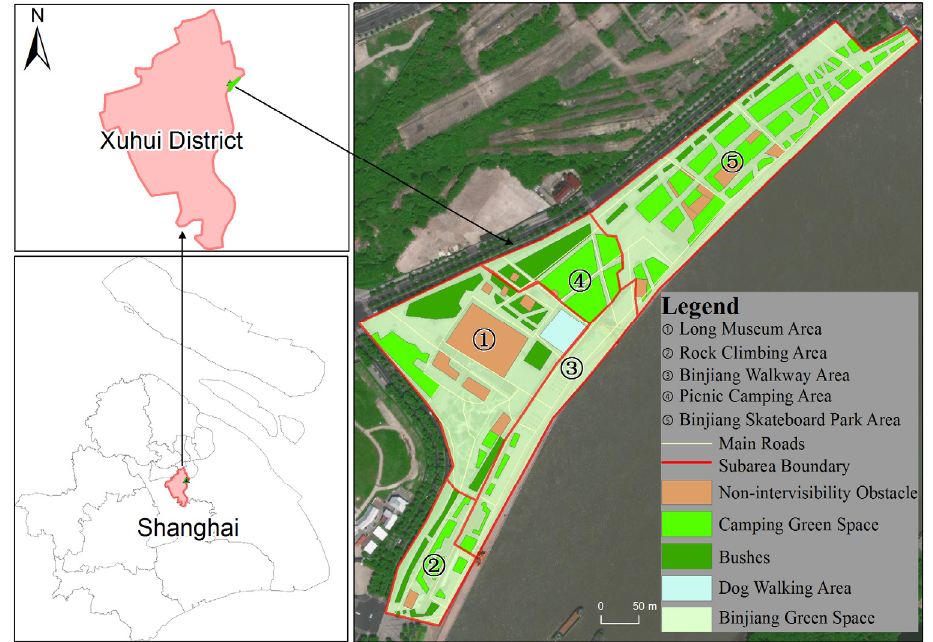
Figure 1. The study area in Binjiang Green Space, Xuhui District, Shanghai, China.